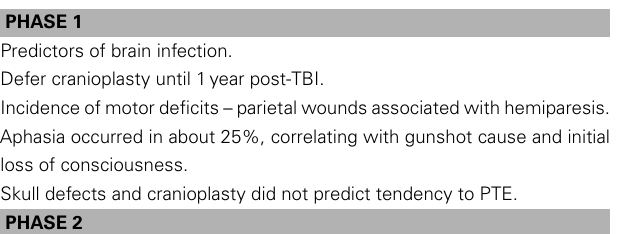
Table 1 | Five key findings of